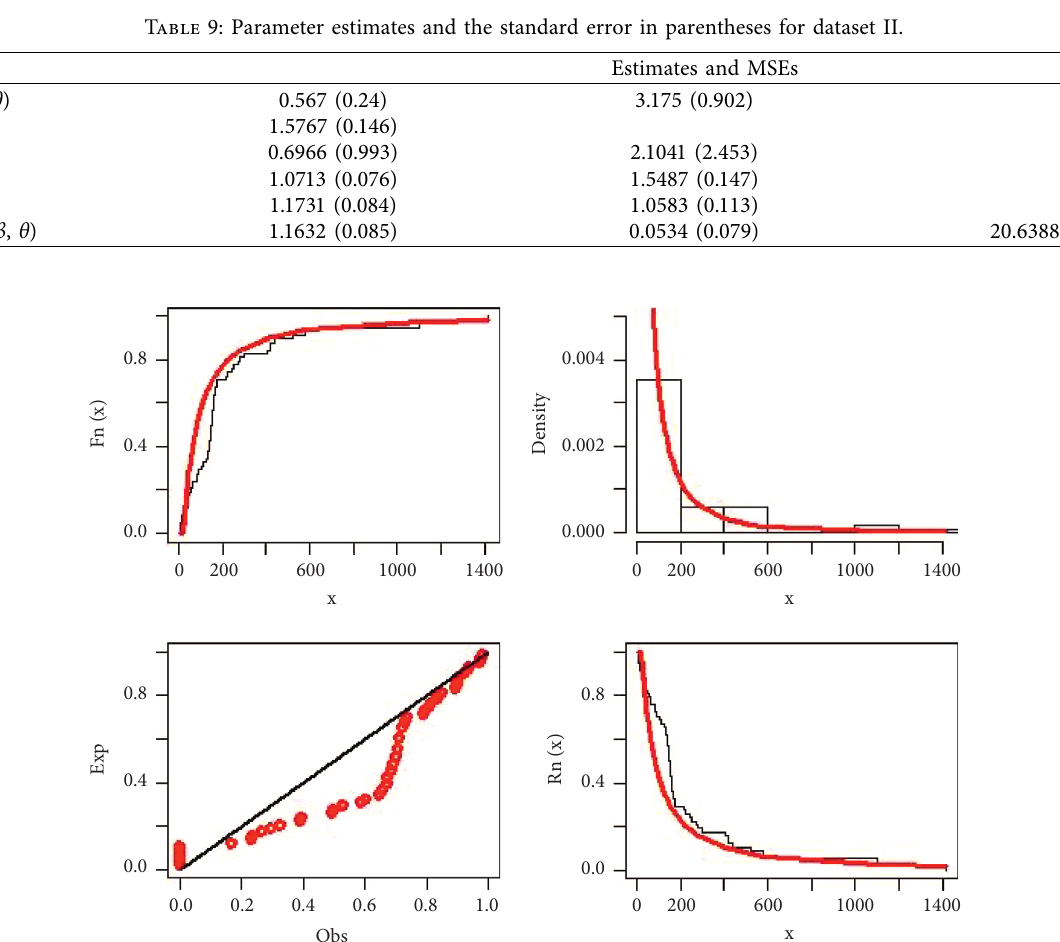
Figure 5: The estimated pdf, ecdf, esf, and pp plots for the TLIL model for dataset